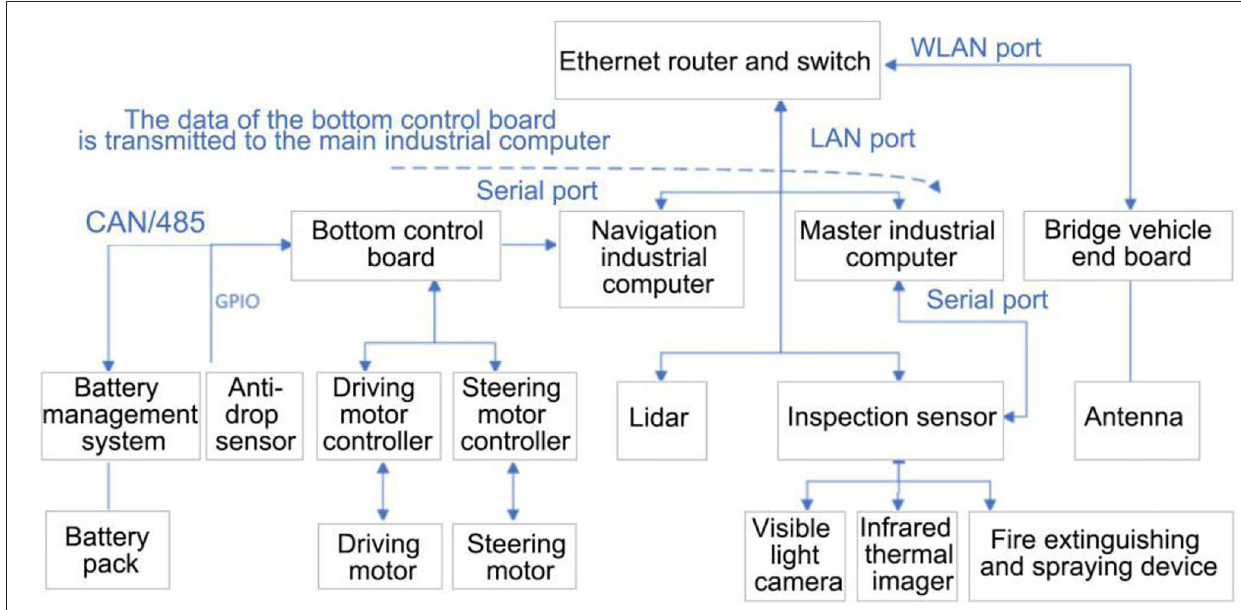
FIGURE 7 | Composition block diagram of vehicle body.